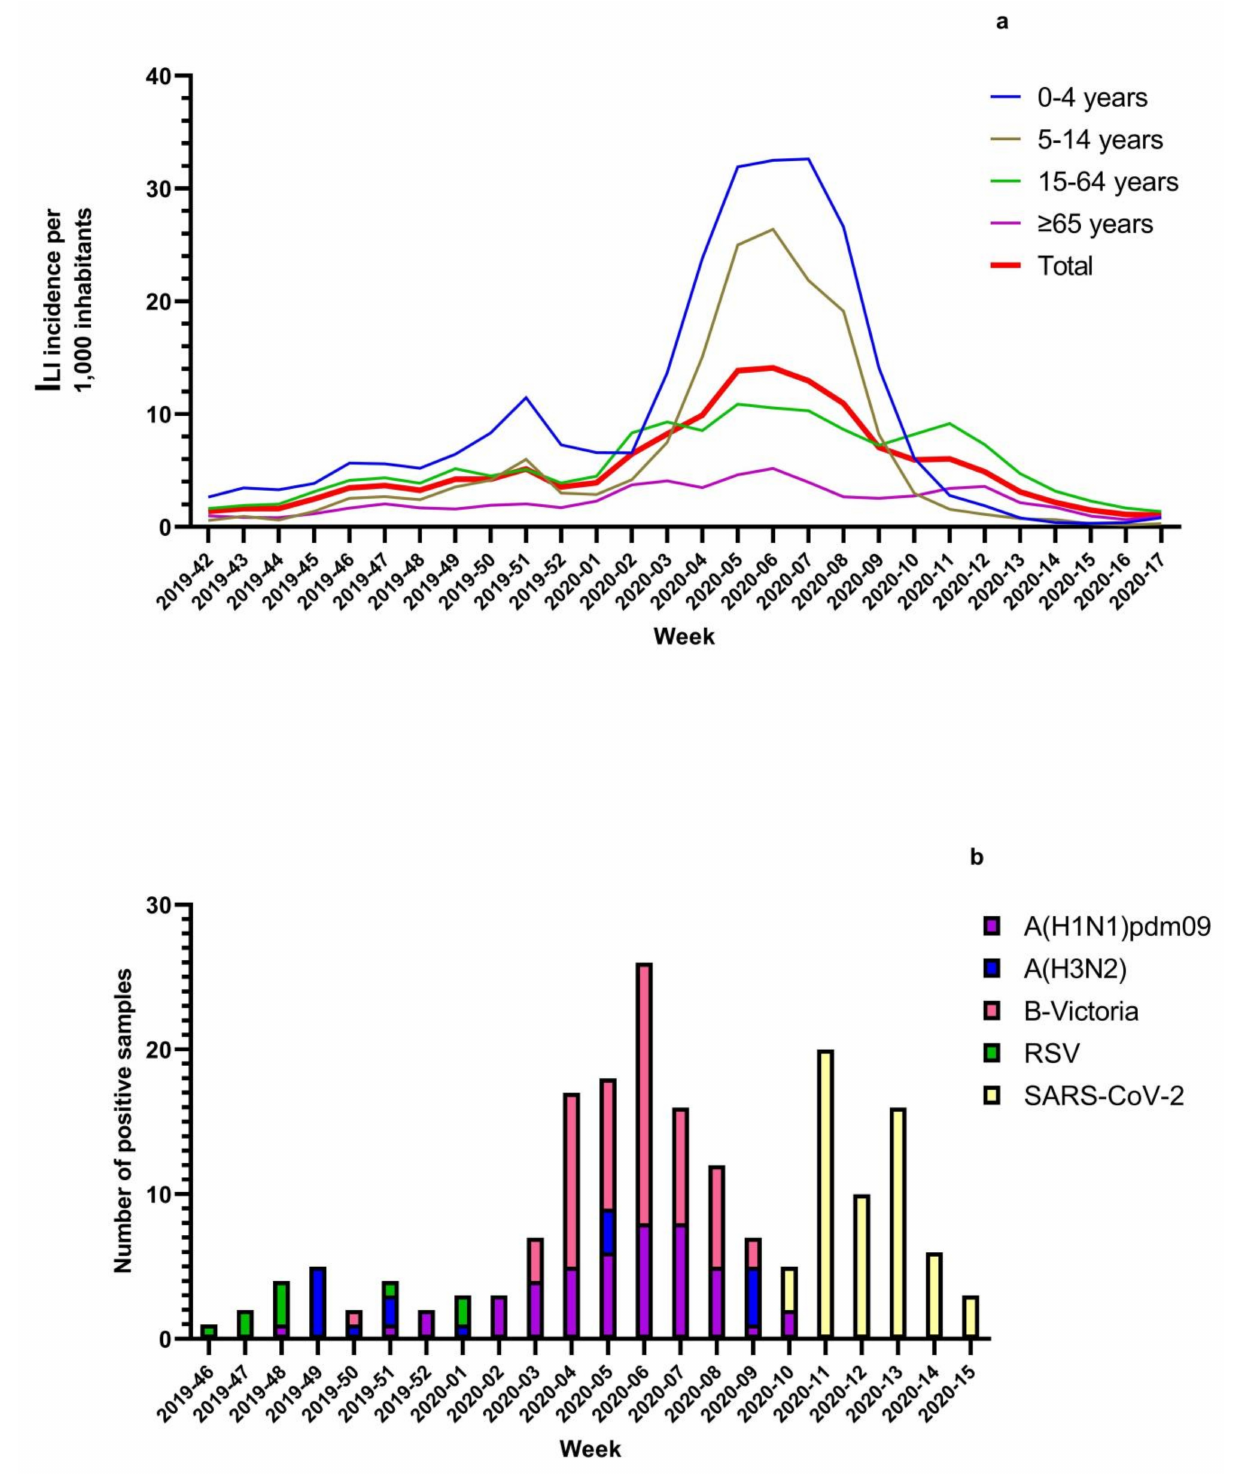
Figure 1. ( a ) Incidence of ILI cases (per 1000 inhabitants) by week, overall (red line), and by age group in Lombardy